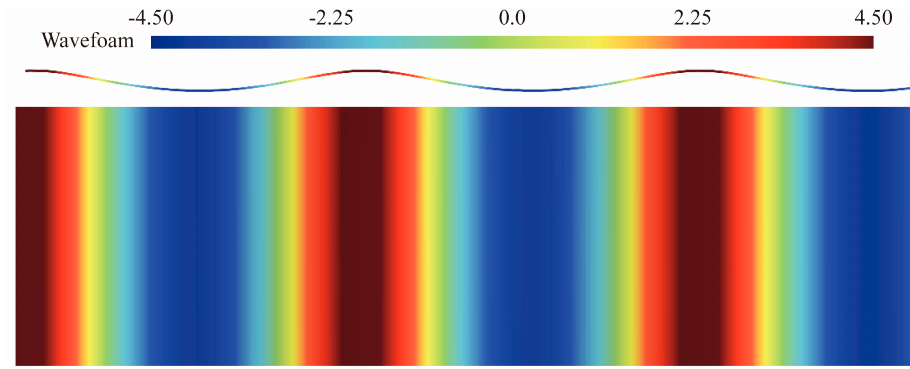
9 of 24 Figure 9. Numerical wave height with time history. Figure 10. Distribution of wave height position points along the propagation direction. The waveform of numerical wave propagation after 20 s is shown in Figure 11. The